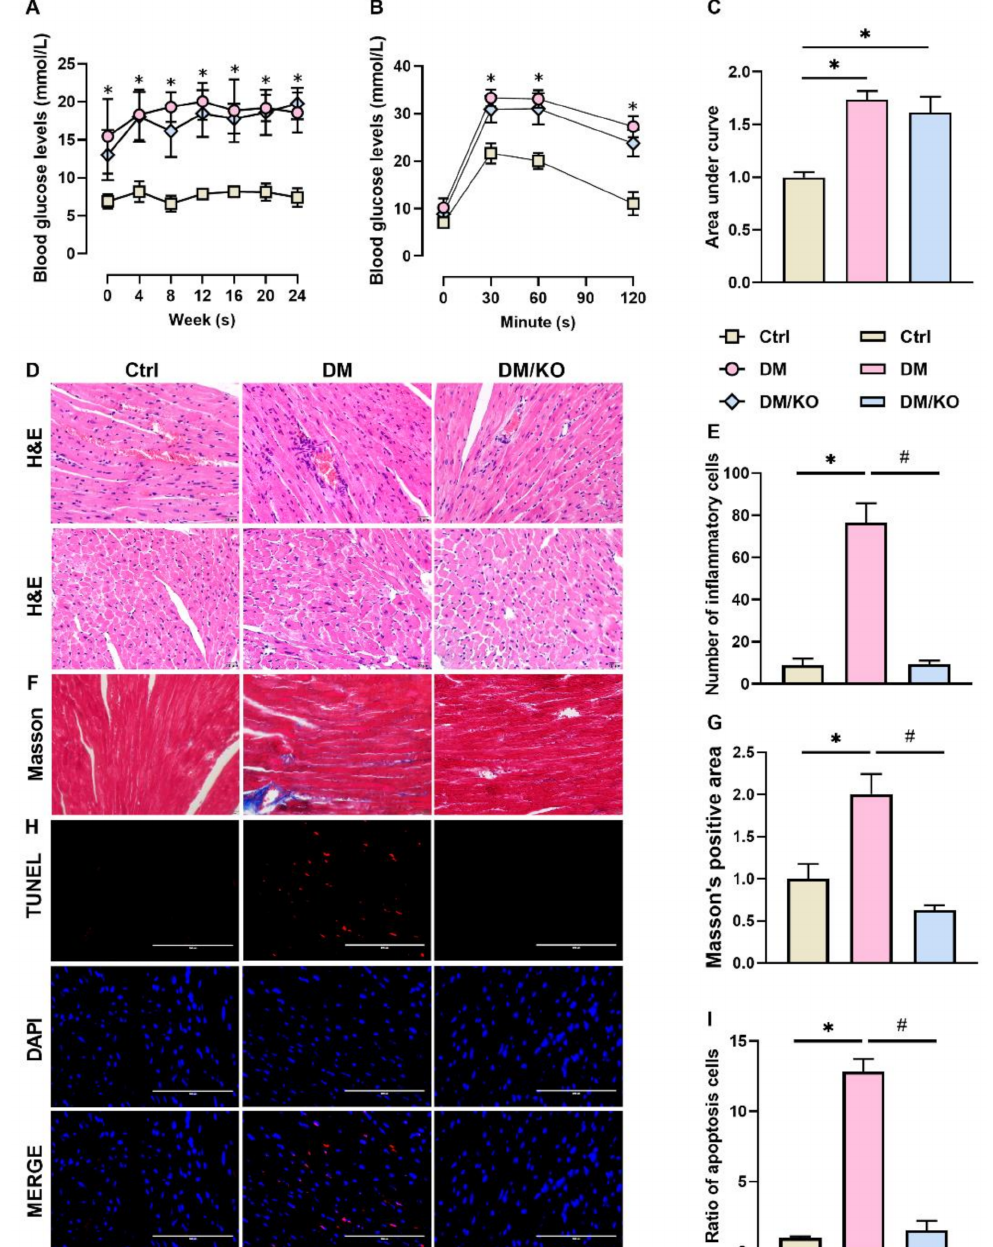
Figure 1. KO alleviated the DM-induced cardiac pathological injuries. ( A ) Blood glucose levels of C57BL/6 male mice were recorded every 4 weeks post diabetes mellitus (DM) onset. ( B ) Glucose tolerance test was performed 22 weeks post DM onset, with ( C ) the areas under the curve quantified. ( D ) Hematoxylin and eosin ( E , H ) staining with ( E ) the number of inflammatory cells infiltrated per vessel quantified (Bar = 20 µ m). ( F ) Masson’s trichrome staining with ( G ) the positive area quantified (Bar = 20 µ m). ( H ) TUNEL staining with ( I ) the ratio of apoptosis cells quantified (Bar = 100 µ m). The data were normalized to Ctrl and summarized as means ± SD. *, p < 0.05 vs. Ctrl; #, p < 0.05 vs. DM. Abbreviations, Ctrl, control; DM, diabetes mellitus; H&E, hematoxylin and eosin; KO, krill oil; TUNEL, terminal deoxynucleotidyl transferase dUTP nick-end